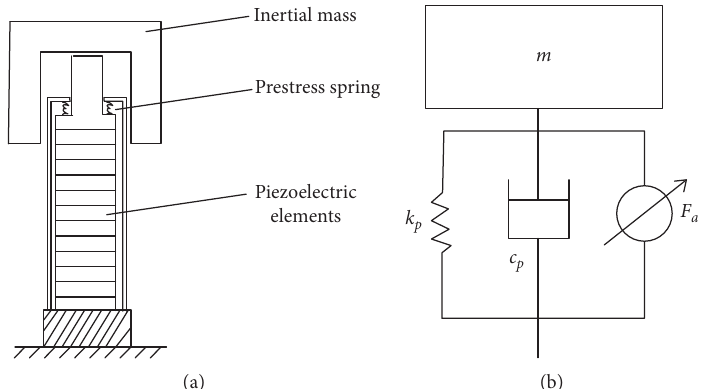
Figure 1: Configuration and model of piezoelectric stack inertial actuator. (a) Schematic configuration. (b) Mechanical model.